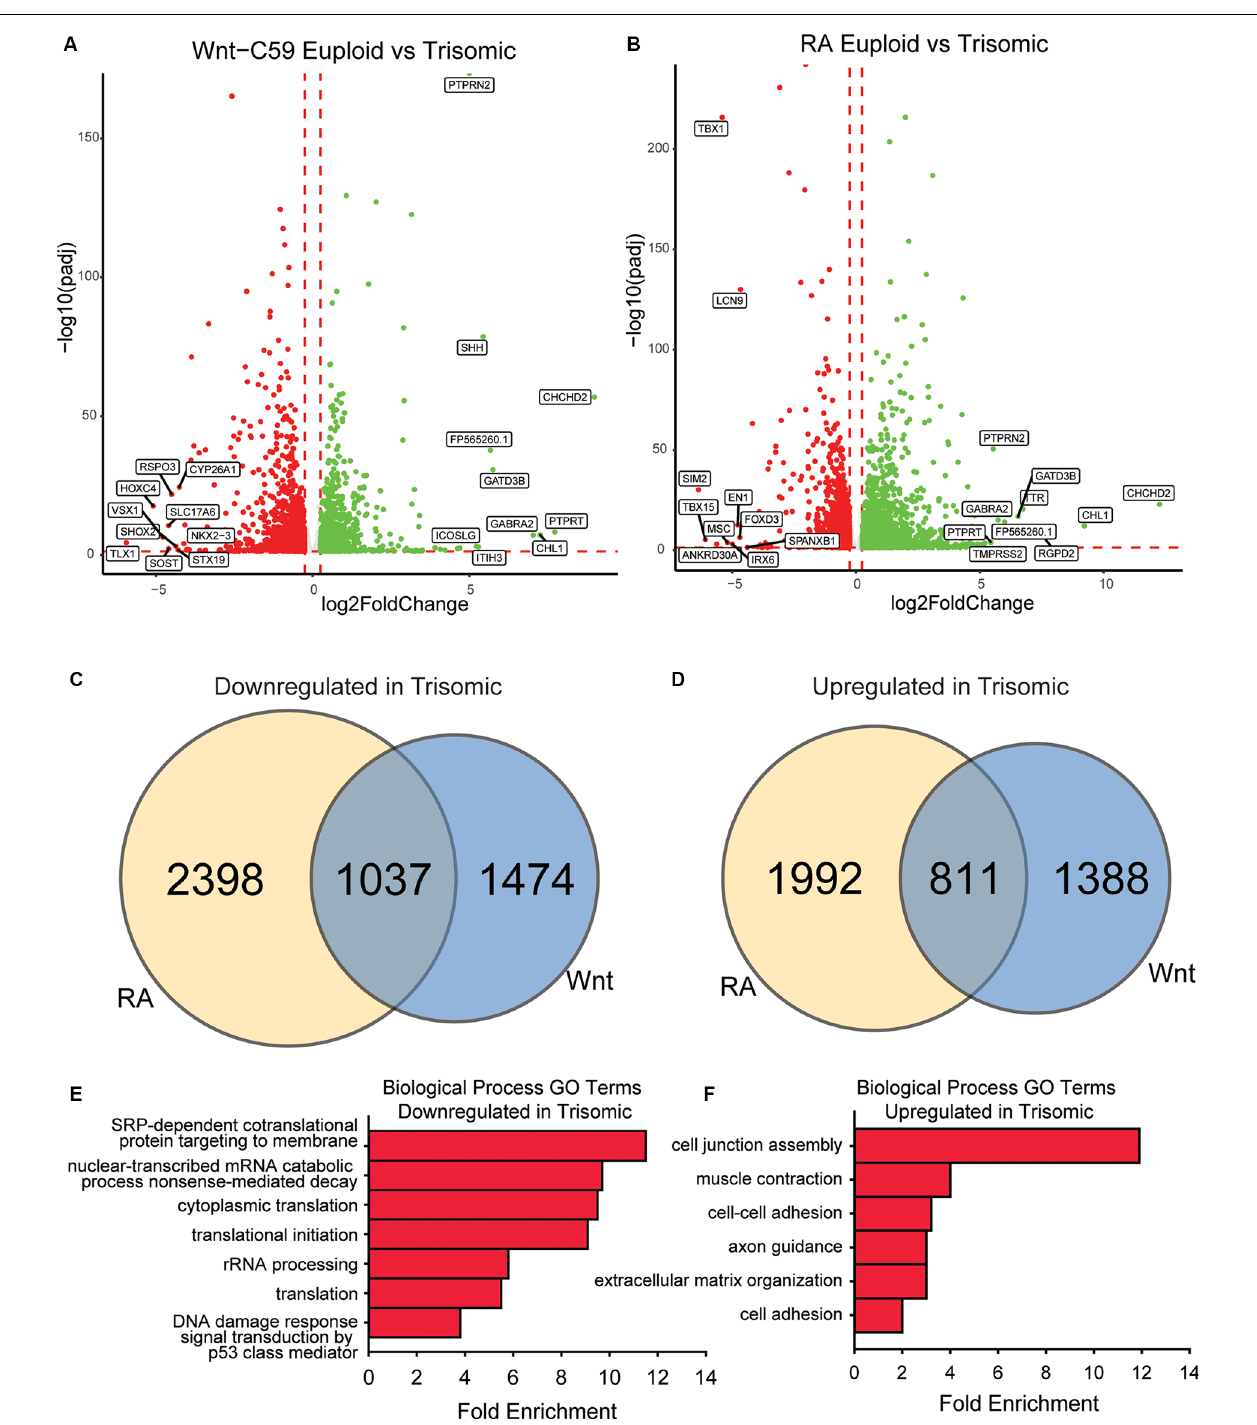
FIGURE 4 | Core DEX genes and patterning-specific differences in trisomic NPCs. (A) There are 4,709 DEX genes between euploid (WC eu ) and trisomic (WC ts ) tNPCs when differentiated with Wnt-C59, 2,199 upregulated in trisomic cells and 2,510 downregulated. (B) There are 6,238 DEX genes between euploid (WC eu ) and trisomic (WC ts ) tNPCs when differentiated with RA, 2,803 upregulated in trisomic cells and 3,435 downregulated. (C) Of the genes downregulated in the trisomic cultures, only 21.1% (1037) are in common between the Wnt-C59 and RA conditions. (D) Of the genes upregulated in the trisomic cultures, only 19.4% (811) are in common between the Wnt-C59 and RA conditions. (E) GO analysis identifies biological processes involving translation as significantly enriched in the genes that are downregulated in trisomic cells in both conditions. (F) GO analysis identifies biological processes involving the extracellular matrix and cytoskeleton as significantly enriched in the genes that are upregulated in trisomic cells in both